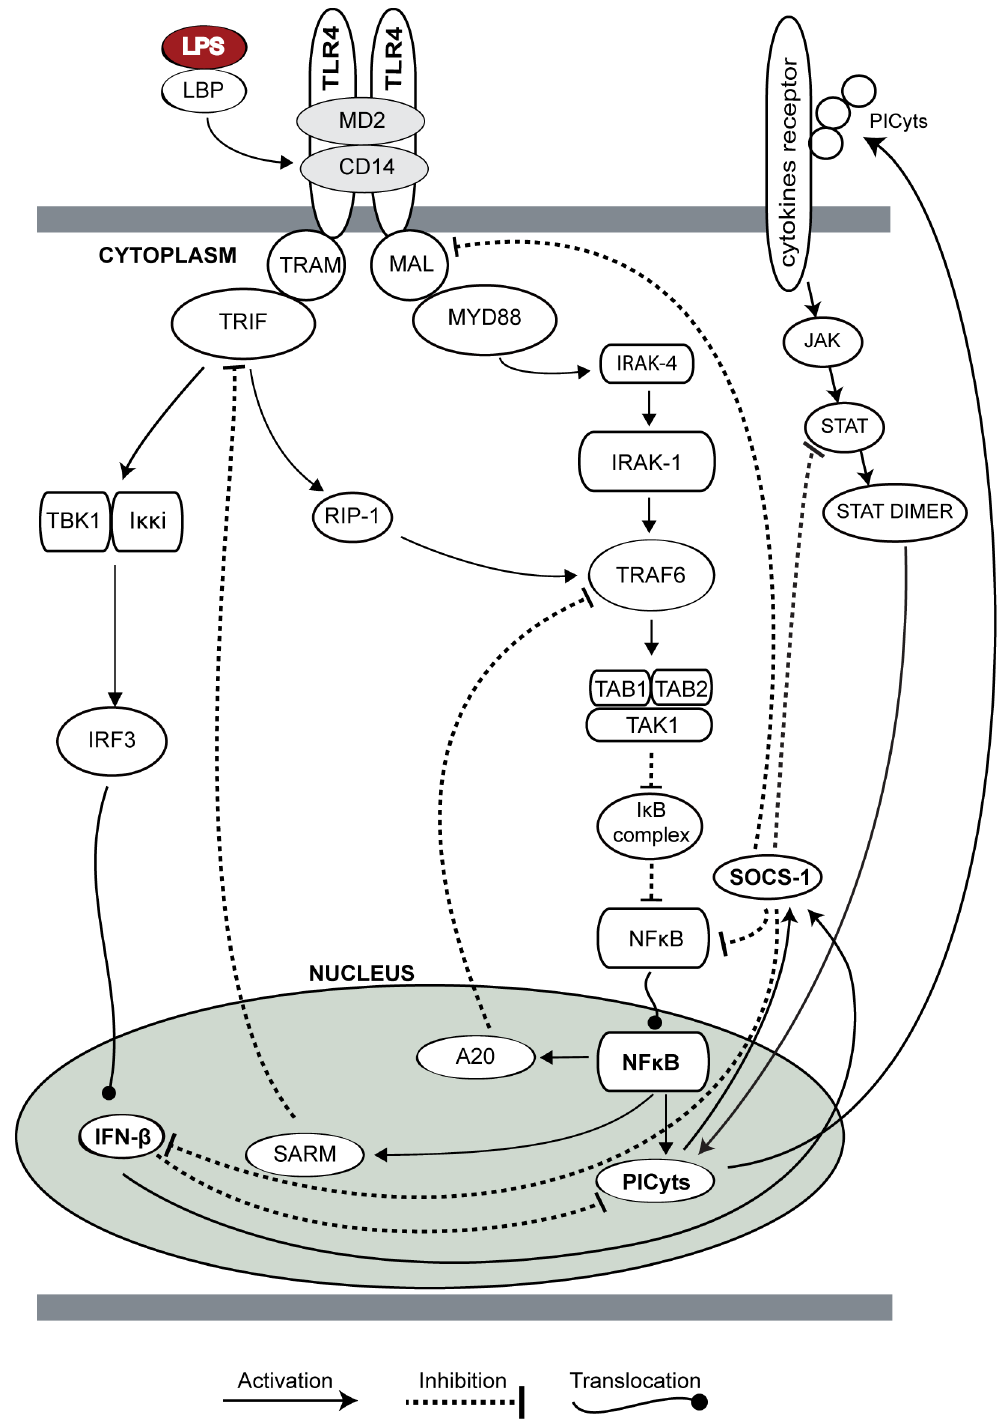
Figure 1. TLR4 and JAK/STAT signalling pathway. Overview of TLR4 and JAK/STAT signalling pathway adopted from previous experimental studies and databases associated with signalling pathways [20,28–33]. TLR4 activates two separate signalling pathways, including MyD88 and TRIF dependent pathways [103]. TIRAP/Mal and TRAM are recruited by TLR4 as adaptor proteins to activate MyD88 and TRIF dependent pathways, respectively [35,103]. Following MYD88 activation, IRAK4 is phosphorylated by MyD88-MAL complex, which ultimately results in the phosphorylation of IRAK1 protein. Phosphorylated IRAK1 activates TRAF6 [104] which after forming a complex with TAK1-TAB1/2 activates I kk complex [105]. I kka and I kkb catalyse the phosphorylation of I k B, resulting in its dissociation from NF k B. Afterwards NF k B translocate into nucleus [106] and transcribes PICyts which results in the subsequent induction of SOCS-1 [48,107]. Along with PICyts, SARM and A20 are also transcribed by NF k B which inhibit TRIF and TRAF6, respectively [44,108]. Interaction of SOCS-1 with MAL results in its polyubiquitylation and degradation of MAL [42]. SOCS-1 also result in the degradation of NF k B after binding with its p65 subunit [109]. Moreover, it is also responsible for inhibiting PICyts mediated JAK/STAT signalling [110]. The alternate pathway for the MyD88 independent induction of NF k B is TRIF which associates with RIP-1 and induce TRAF6 [111]. Cytoplasmic